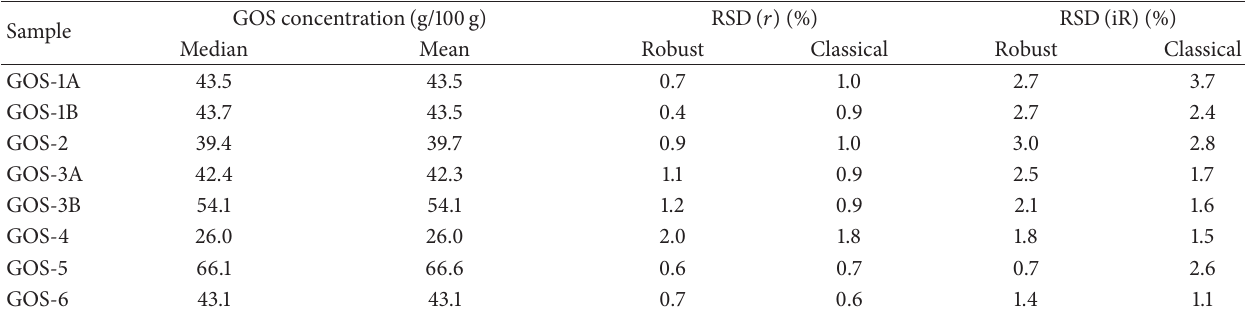
Table 3: Precision of GOS analyses in ingredients using both robust and classical statistics.